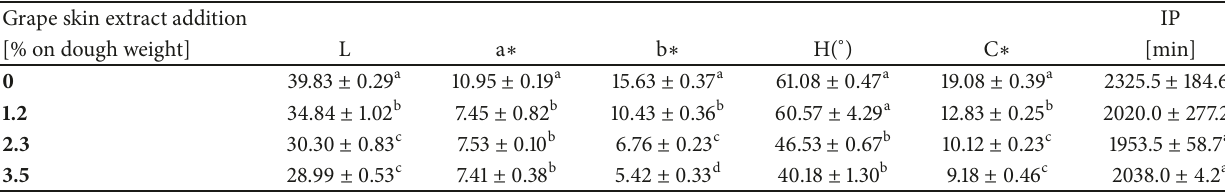
Table 3: Influence of the addition of encapsulated grape skin extract at different levels on colorimetric parameters and induction period (IP) of biscuits. Values are means ± SD (n = 3). The same superscript letter under each parameter indicates the means are not statistically different according to analysis of variance (ANOVA) and Tukey’s post hoc test (p < 0.01).